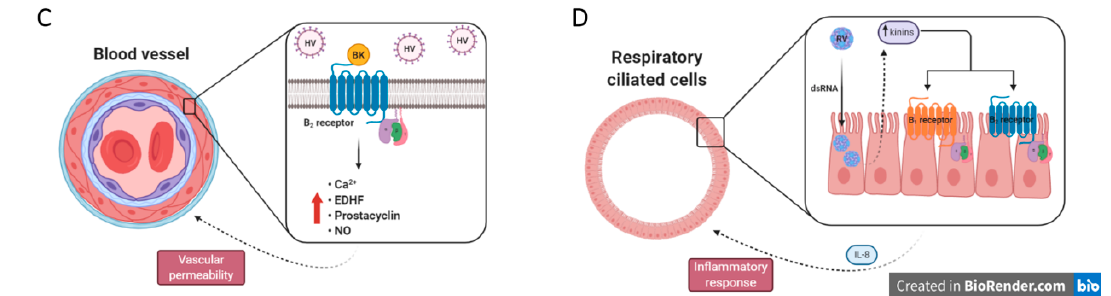
Figure 2. The role of kinin system in viral infections. ( A ) The kallikrein–kinin pathways and their intermediates, including enzymes, active metabolites, and receptors. In addition, the current pharmacological targets to modulate the system (e.g., lanadelumab and icatibant). Dashed lines designate the ligands and their respective receptors. ( B ) Hypothetical mechanism of crosstalk between SARS-CoV-2 and the kinin system, in which it could be one of the responsible routes for the worsening of Covid-19 clinical evolution. ( C ) Hantavirus (HV) modulates the bradykinin (BK)–B 2 receptor axis promoting the release of Ca 2+ , endothelium-derived hyperpolarization factor (EDHF), prostacyclin and, nitric oxide (NO). Consequently, increasing the vascular permeability. ( D ) The “common cold virus”, called Rhinovirus (RV), has been suggested to enhance the expression of BK receptors (B 1 and B 2 ) by increasing the kinin agonists (i.e., BK, kallidin, and des-Arg 9 -BK) in nasal secretion of patients with respiratory syndromes. LMWK = low molecular weight kininogen; HMWK = high molecular weight kininogen; ACE2 = angiotensin-converting enzyme 2.